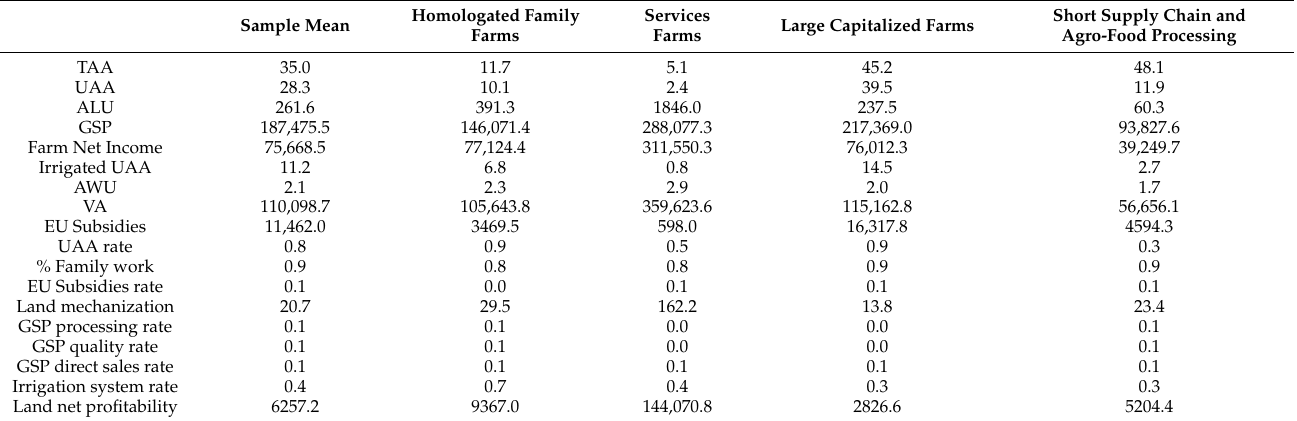
Table A2. Description of the average values of the main structural variables and of the main indexes by cluster identified in the northeast geographical breakdown (2020).